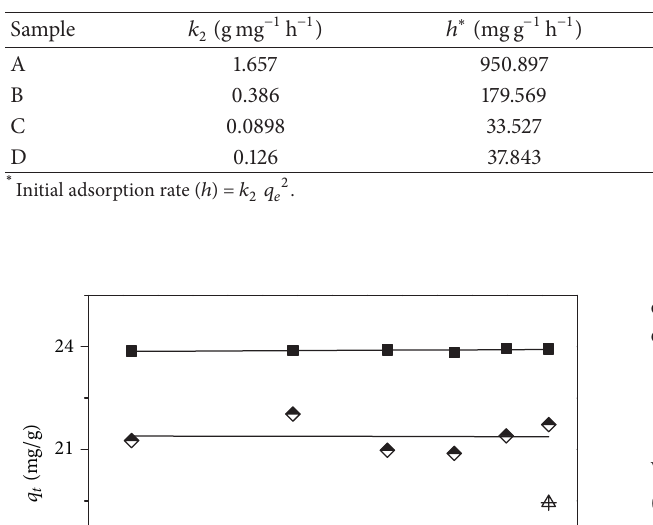
Table 1: Lagergren pseudo-second order kinetic model parameters for strontium removal.